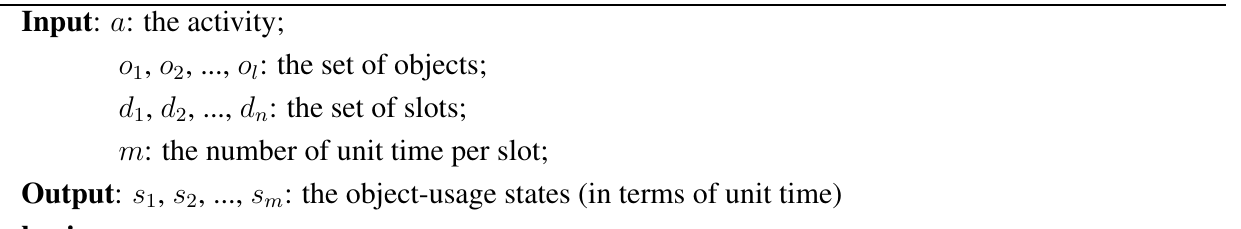
Algorithm 1 : Object-usage interpretation